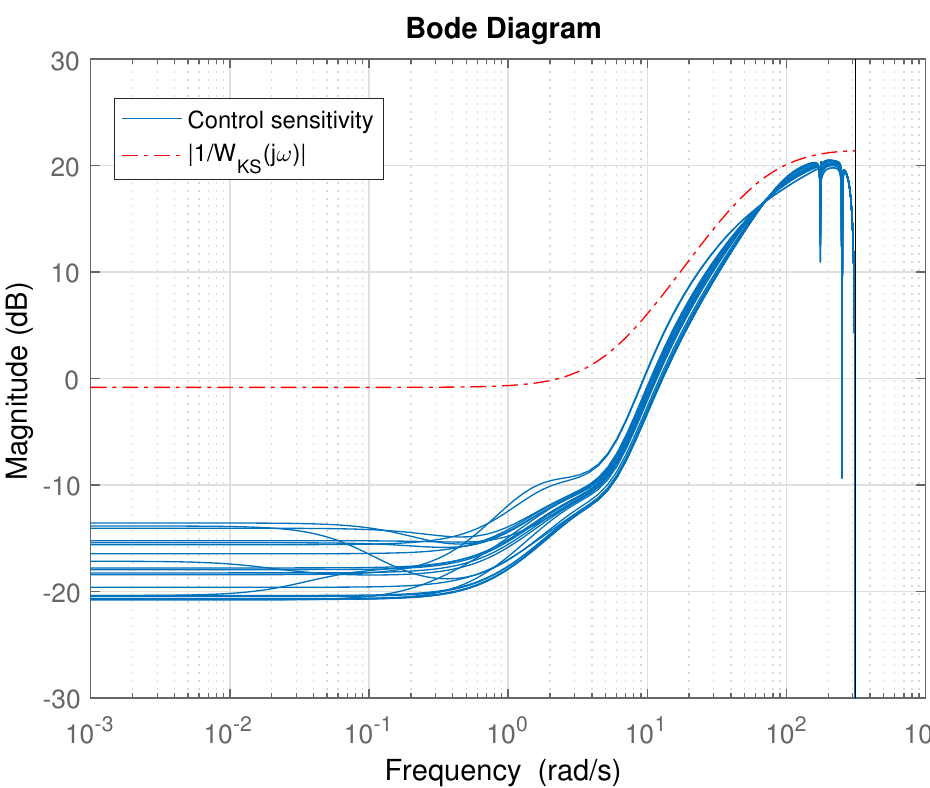
Figure 11. Sensitivity of the control action to the reference compared with its inverse weighting